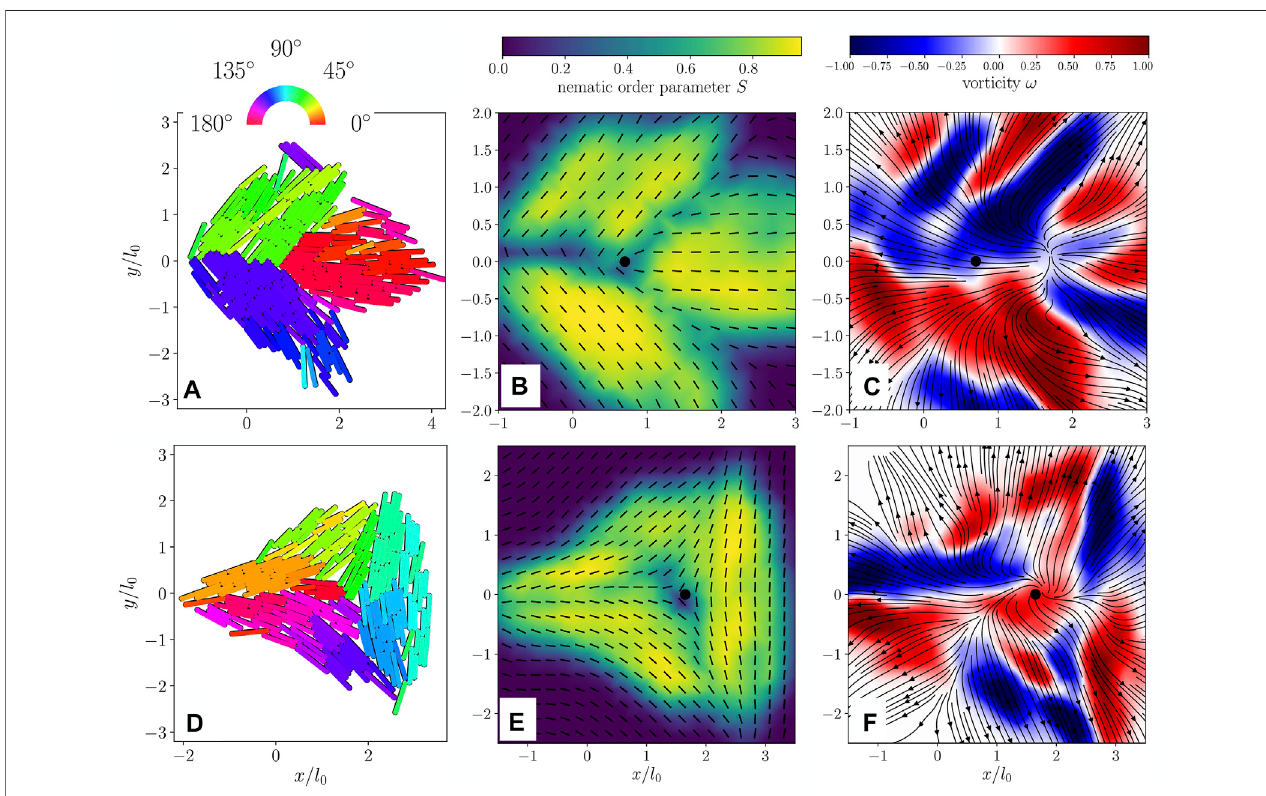
FIGURE2|(A) Simulatedcon fi gurationofanisolated+1/2defect.Colorcodeshowstheorientationofeachrod. (B) Nematicdirector fi eld(blacklines)andnematic order parameter (color code) extracted from the con fi guration in (A) . (C) Flow fi eld (black lines) and vorticity (color code) extracted from the con fi guration in (A) . (D) Con fi guration ofan isolated − 1/2 defect. (E) Nematic director (black lines) and order parameter (color code) extracted from the con fi guration shown in (D) . (F) Flow fi eld (black lines) and vorticity (color code) extracted from (D) . The black fi lled circle in (B,C,E,F) shows the location of the defect core. Particles have aspect ratio l 0 / d 0 =